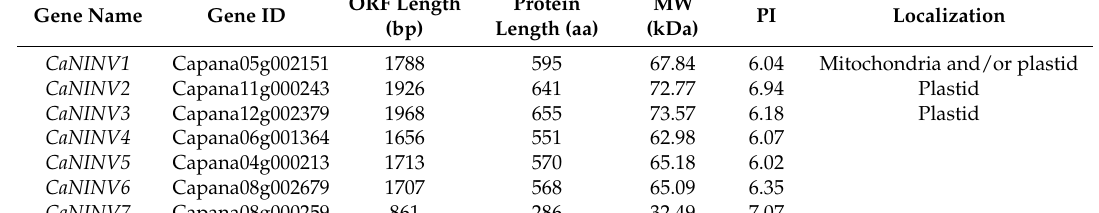
Table 1. Basic information of seven pepper alkaline/neutral invertase genes ( CaNINVs ).